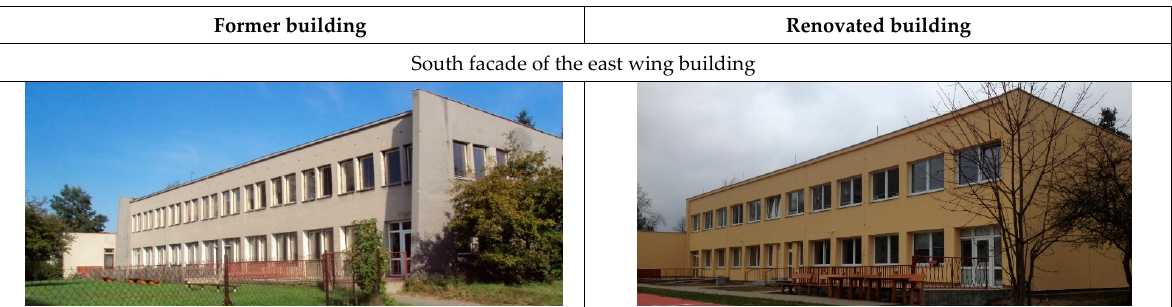
Figure 2. Part of the plan of the ground floor of the east wing of the school building with the studied classroom.